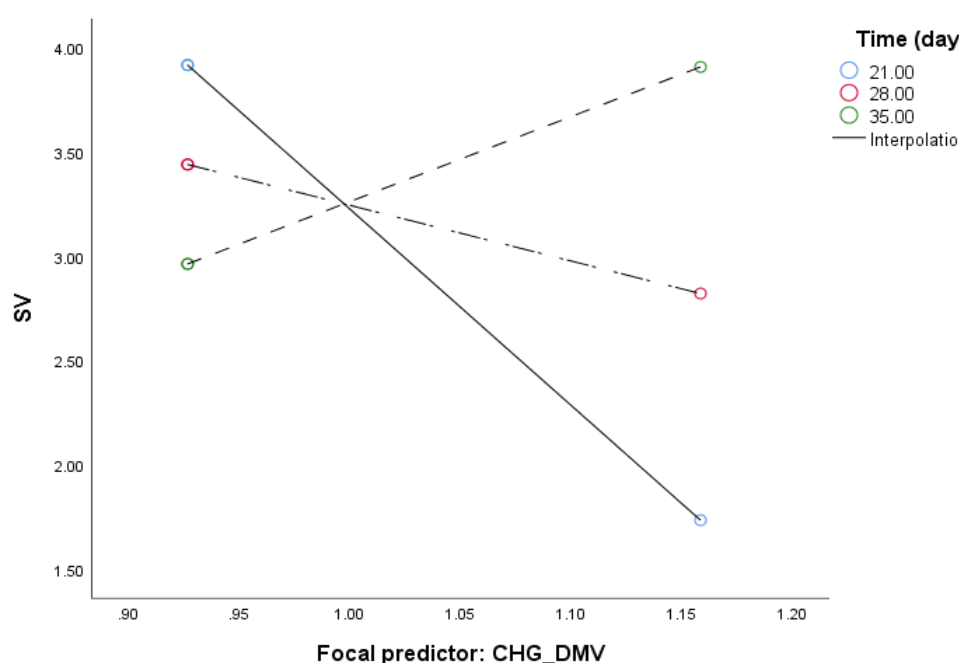
Figure 5. Conditional effect of demethylation of the CHG sequence context (CHG_DMV; predictor) under different durations of in vitro anther culture.